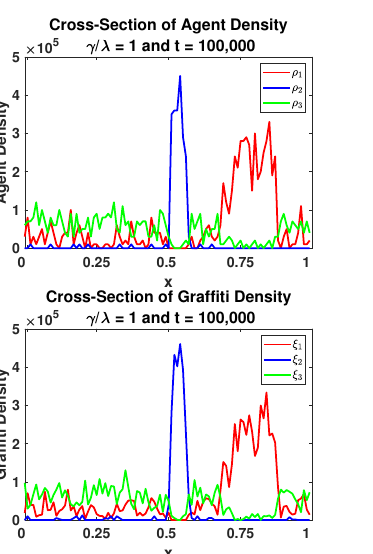
Figure 12. Here, we plot graphs of the beta values β j against the percentage of the area dominated by gang j for the Timidity Model (variation 1). We use six sets of parameters, enumerated in Table 1.